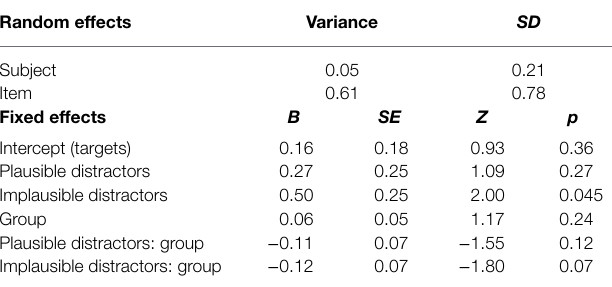
TABLE 4 | Model output of glmer for accuracy by condition and group.